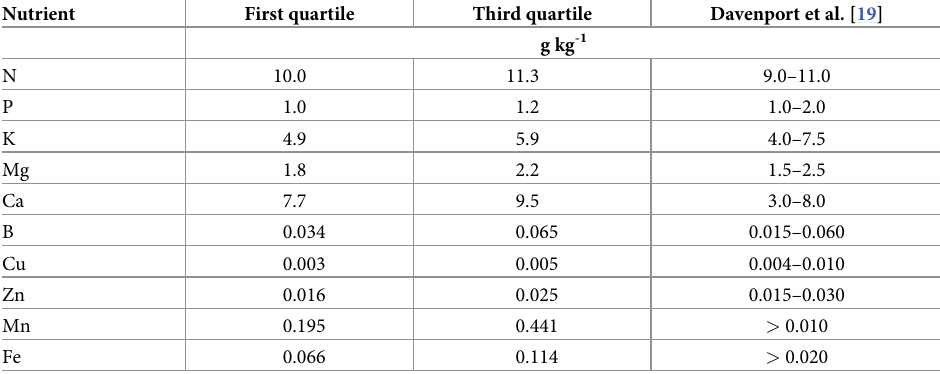
Table 4. Intervals of compatibility of quartile nutrient concentrations in plant tissues (leaves and stems) of true negative specimens across factors compared to published